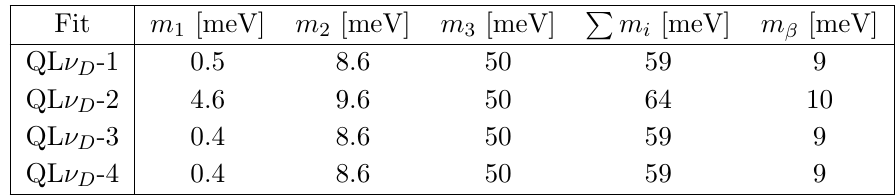
< 20. In brackets indicated are the values preferred by O (1)